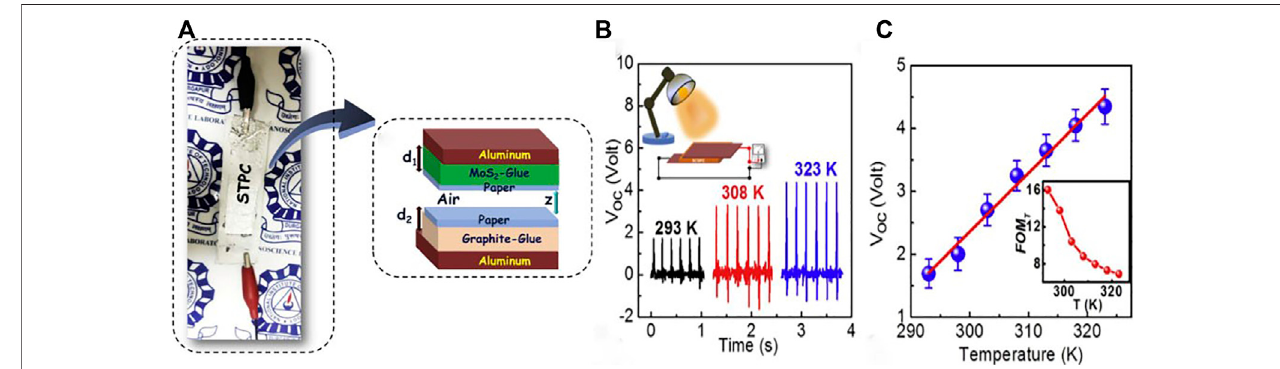
FIGURE 6| (A) Optical image and schematic drawingof STPC, (B) variation of average V oc ofSTPC at 293, 308, and 232 K under aconstant periodic pressure of 1 kPa, and the schematic ofmeasurementtechnique isshown inthe inset, (C) the linear fi tted curve of V oc vs . temperatureat thetemperature region of293 – 323 K,and the relative sensitivity coef fi cient (S) of V oc with temperature is shown in the inset (Karmakar et al., 2019).